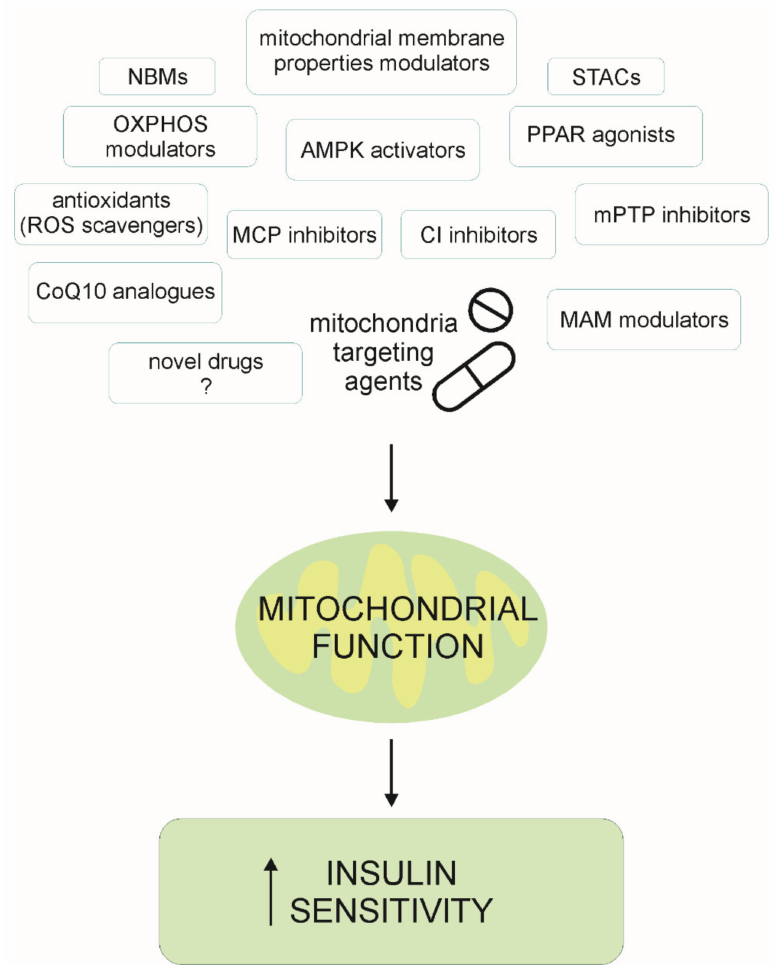
Figure 2. Potential mitochondria targeting agents that might improve insulin sensitivity through modulation of mitochondrial function. They are grouped based on the strategy of their pharmaco- logical actions, which implies potential molecular mechanisms: NBMs (NAD+ boosting molecules), mitochondrial membrane properties modulators, STACs (Sirt1-activating compounds), OXPHOS modulators, AMPK activators, PPAR agonists, antioxidants (ROS scavenger), MCP (mitochondrial pyruvate carrier) inhibitors, CI (respiratory complex I) inhibitors, mPTP (mitochondrial permeability transition pore) inhibitors, CoQ10 (coenzyme Q10) analogues, mitochondrial-associated ER mem- branes (MAM) modulators and novel drugs to be designed. Symbols: ? = unknown drug—to be designed; ↑ =